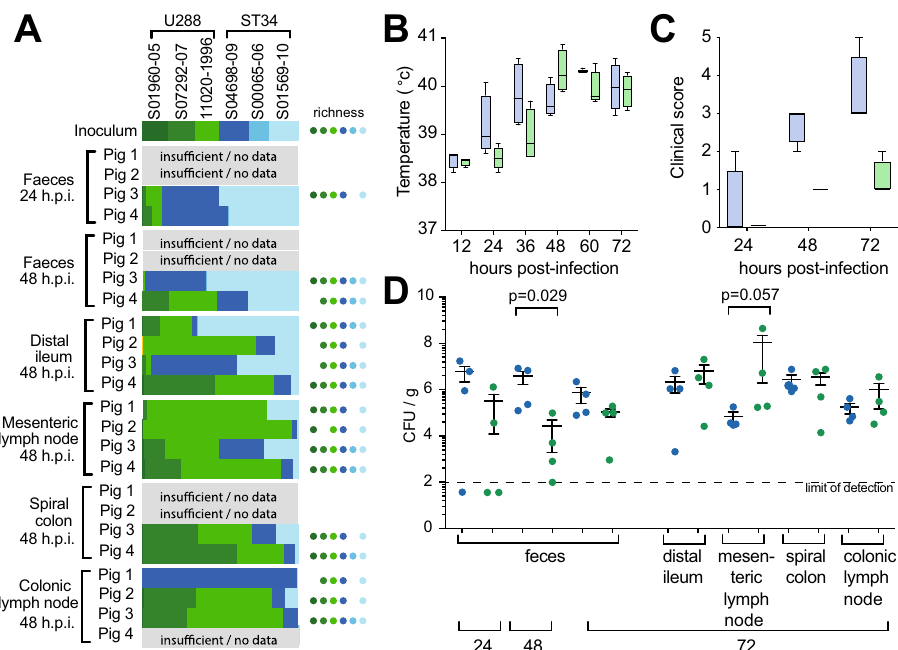
Fig. 7 Colonisation and clinical signs of disease following oral inoculation of pigs with S. Typhimurium U288 and ST34. A Four pigs were challenged orally with an inoculum containing six wild-type independently tagged strains (WITS) of S . Typhimurium (three DT193 and three U288) in approximately equal proportions. Whole genome sequence of the population of the WITS in the inoculum and recovered from infected pigs was used to enumerate each strain based on the unique sequence tag. The relative abundance of each strain is denoted by bars and the number of strains in each sample (richness) is indicated by circles based on the colour code indicated. Separately, four pigs were challenged orally with S04698-09 (ST34), or 11020-1996 (U288) strains to investigate the signs of disease and colonisation. B – D Groups of four pigs were inoculated with approximately 1 × 10 10 colony forming units of either ST34 S04698-09 (blue bars or circles) or U288 11020-1996 (green bars or circles). B Rectal temperatures of the pigs were monitored over 72 h of infection and C Clinical scores derived from physiological signs and faecal consistency are box plots showing the median interquartile range. D The mean and standard error of viable counts of bacteria shed in the faeces at 24, 48 and 72 h post-inoculation and tissues collected 72 h